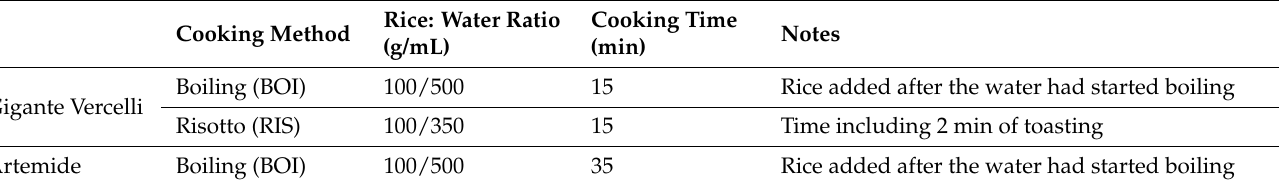
Table 1. The rice cooking conditions used in the